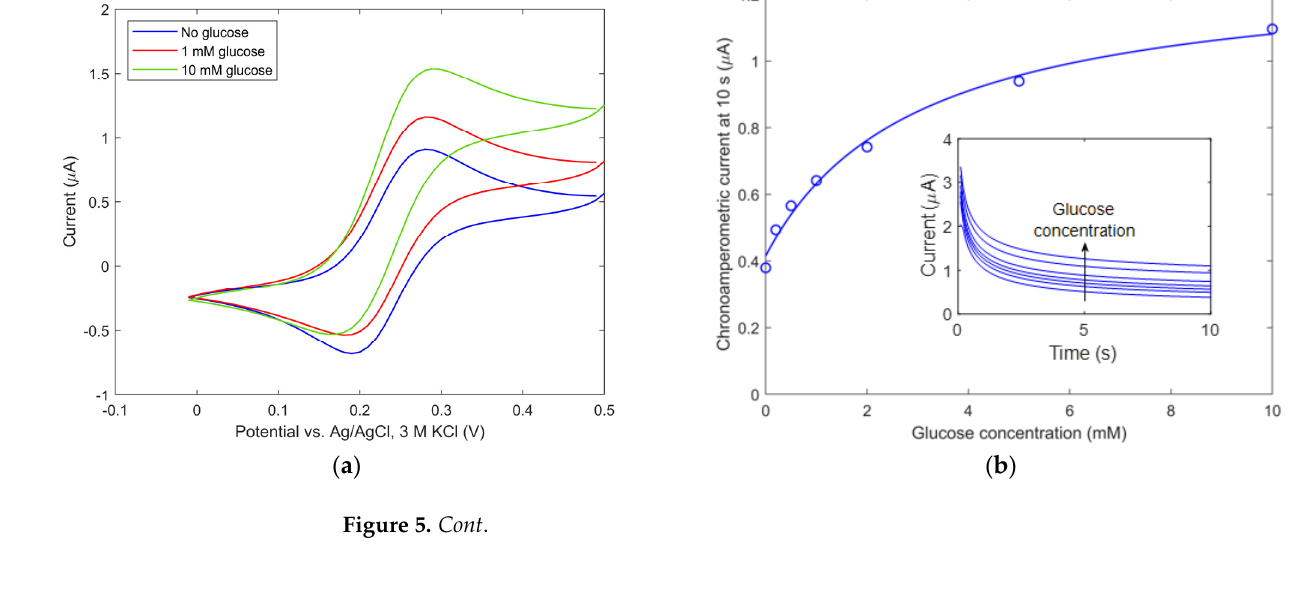
( d ) Figure 5. Immersion mode PQQ-GdhB biosensor electrochemical characterization: ( a ) Cyclic volt- ammogram for different glucose concentrations, measured with large electrodes; ( b , c ) chronoam- perometric current dependency on glucose concentration, measured with large and small elec- trodes. Circles depict measured results and lines depict fitted results; ( d ) normalized chronoam- perometric current dependence on storage time for 0 and 1 mM glucose. The stability of the developed biosensor was evaluated by measuring the chronoam- perometric response signal at different storage time points: immediately, and then 3 and 11 days after biosensor construction. Between measurements, the biosensor was stored in PBS at 4 °C. Figure 5d shows the biosensor response normalized by an initial signal for 1 mM glucose. While the reference signal (measurement without glucose) remained con- stant, the signal for 1 mM glucose decreased with time. After 11 days, the decrease in current was about 45%. It is most likely that the decrease in signal is due to the loss of the PQQ-GdhB enzyme or its activity. 3.2. Microfluidic Mode Biosensor Characterization All results concerning the MM biosensor refer to an experimental setup in which three electrodes (WE, CE, RE) are integrated into the microchannel enabling static or con- tinuous flow (dynamic) measurements (see Figure 2b). The results refer to the large and small electrode design with appropriately adapted microchannels. Potential and flow dependence. MM characterization of the PQQ-GdhB biosensor on glucose is shown in Figure 6. The appropriate DC potential (E DC ) for chronoamperometric